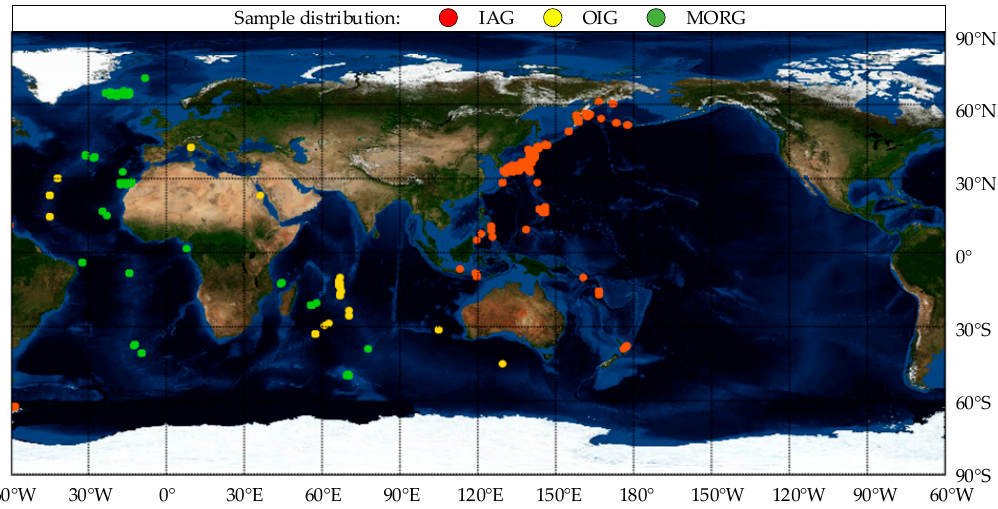
Figure 9. Distribution of gabbroic rock samples.